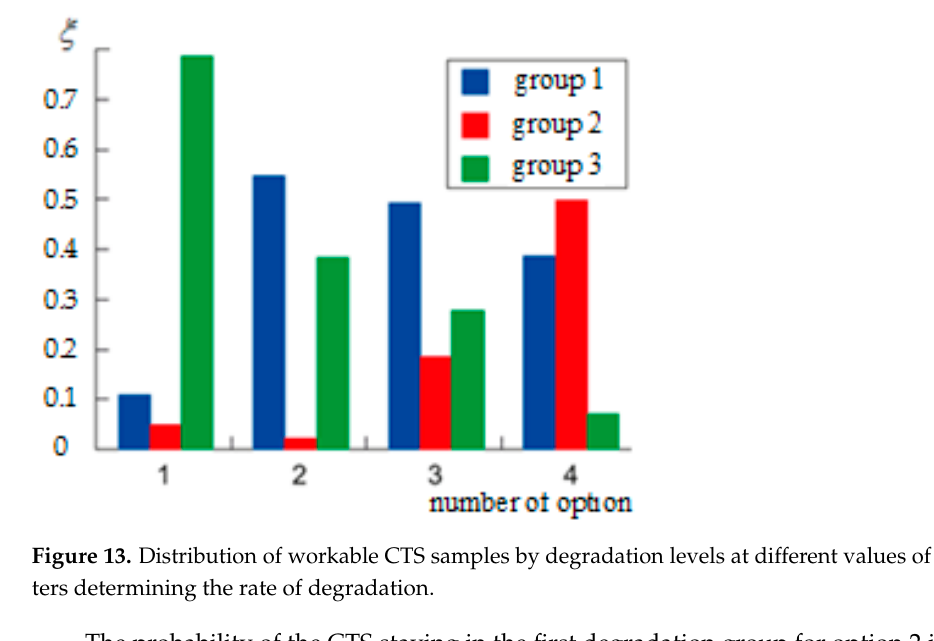
20 of 25 Figure 12. The dependence of the readiness coefficient